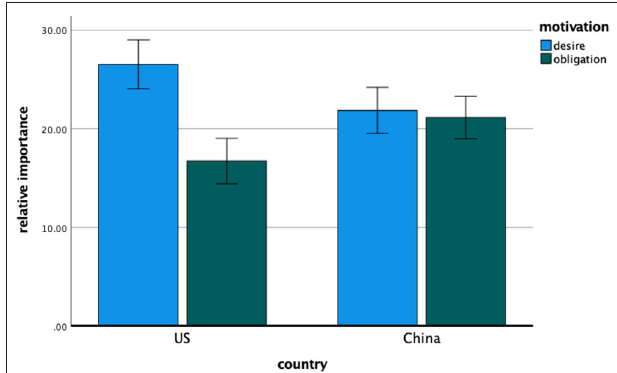
FIGURE 1 | Study 1—the relative importance of desire and obligation motivation for American and Chinese participants. Error bars denote 95% confidence intervals of the